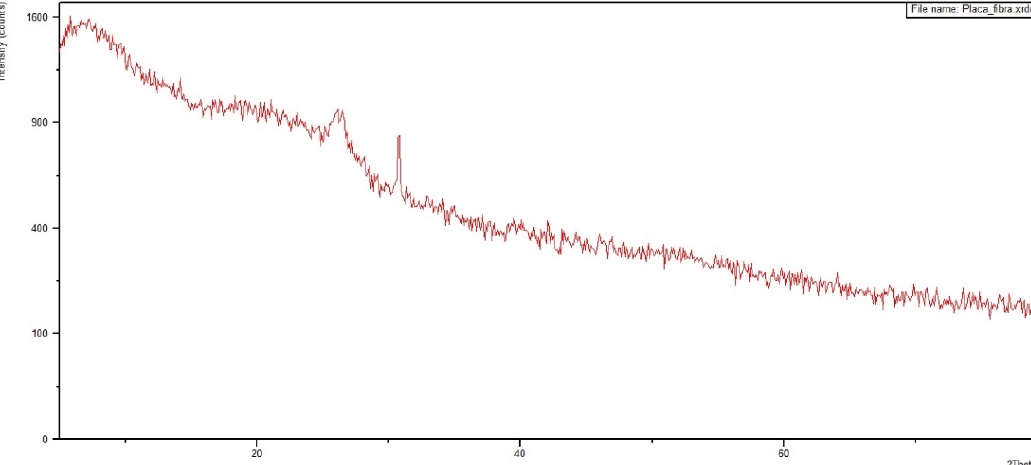
Figure 14. Diffractogram of plain epoxy resin. Figure 15. Diffractogram of the plain ramie fabric.